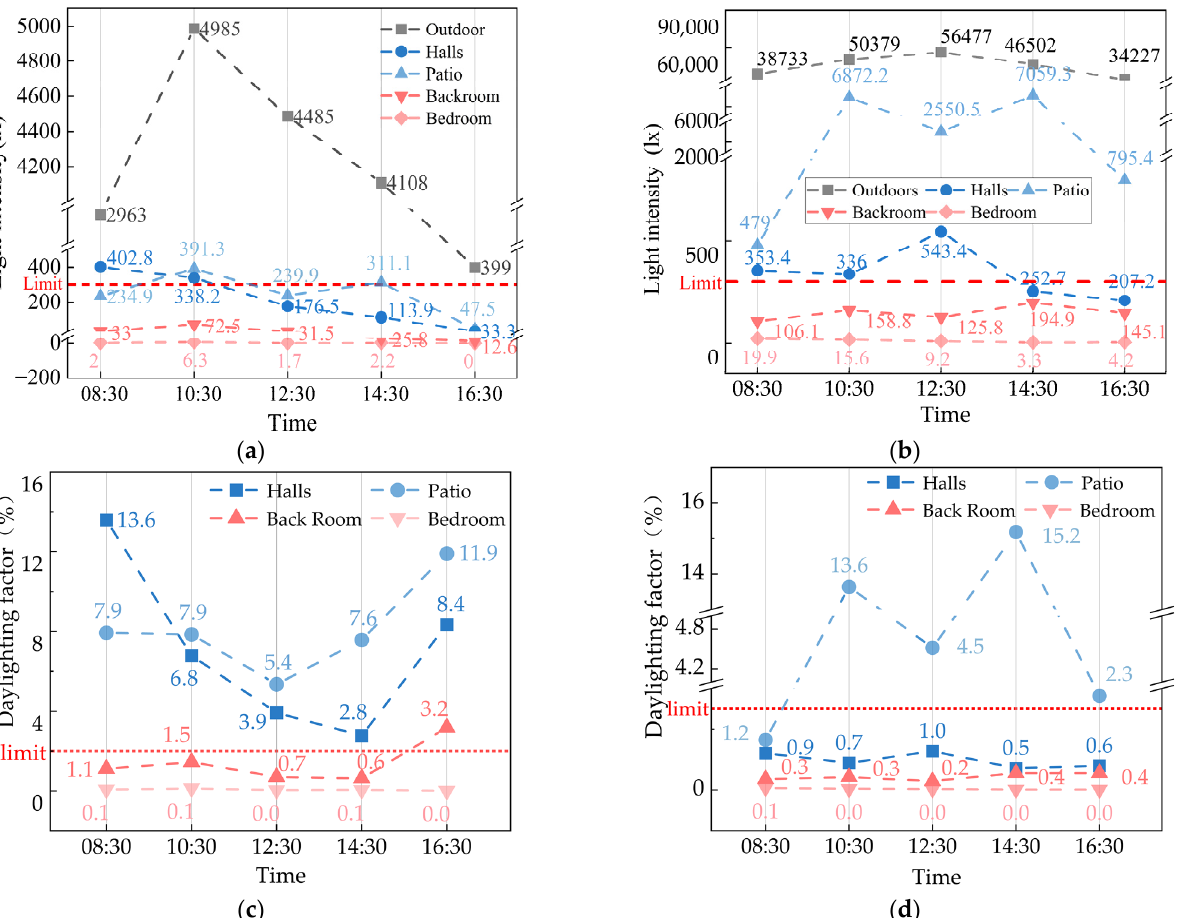
Figure 14. Indoor light environment monitoring results of “Yao’s House”. ( a ) Light intensity distribution in winter; ( b ) light intensity distribution in summer; ( c ) indoor daylighting in winter; and ( d ) indoor daylighting factor in summer.